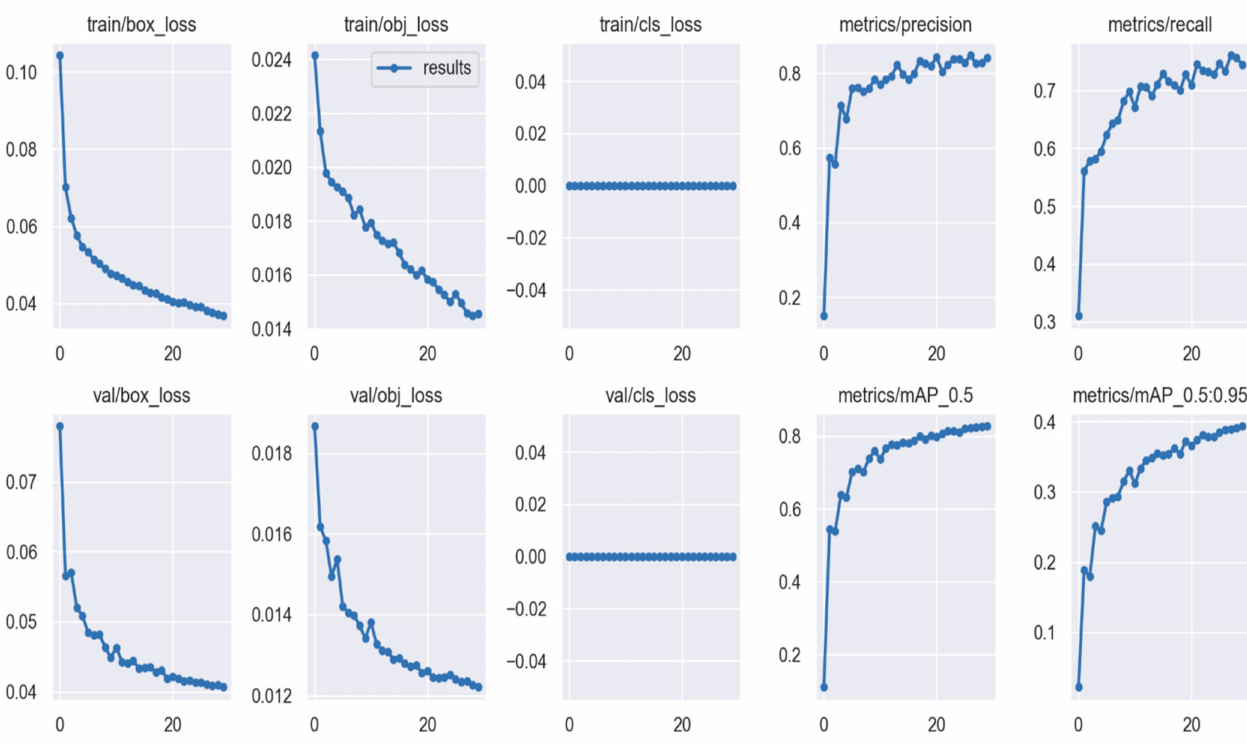
Figure 7. Training and validation performance with Yolo